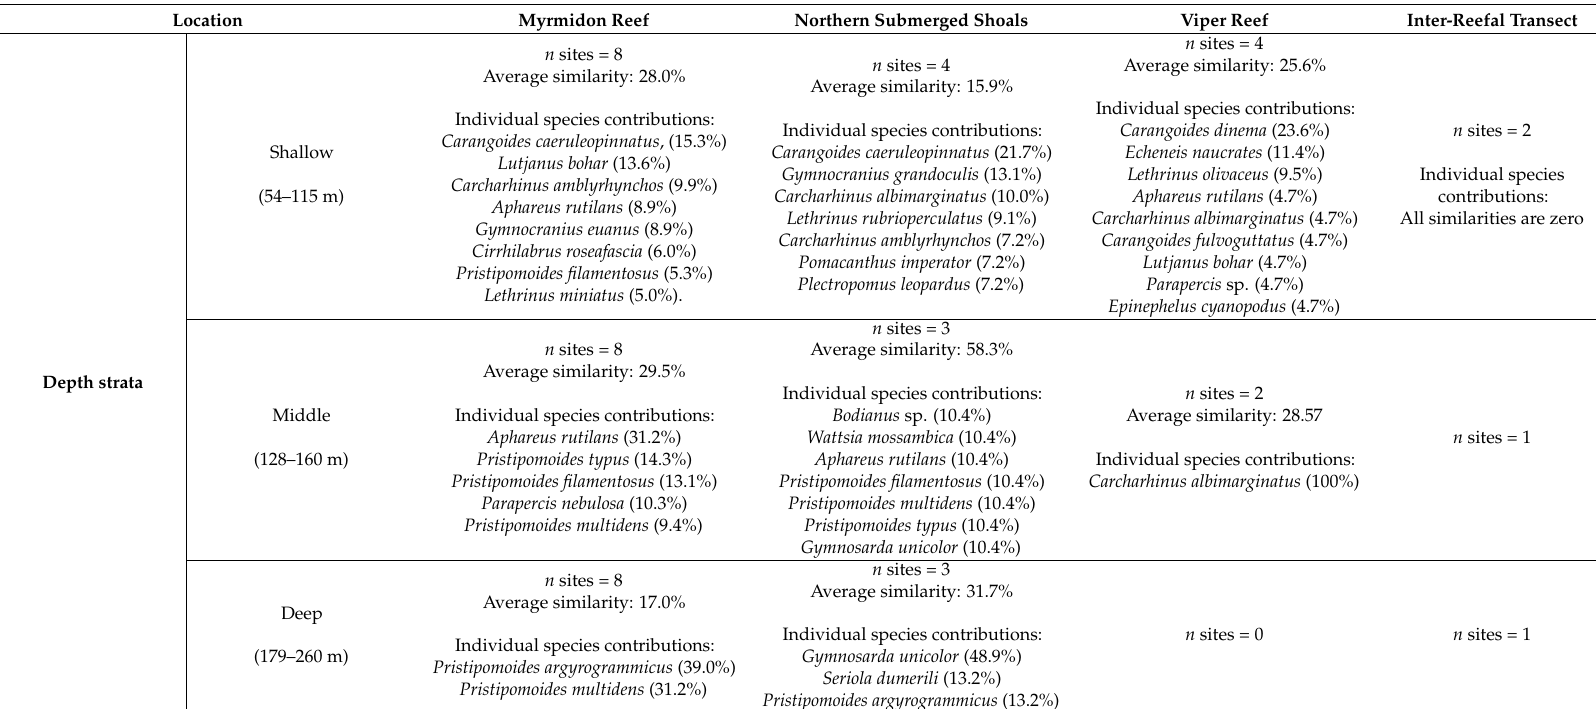
Table 2. Similarity percentages (SIMPER) analysis on deep-reef fish community data described the relative contributions of specific species to the dissimilarities between sites (among locations) with percent contribution of individual species to those differences. Species abundances were presence/absence-transformed, and Bray-Curtis similarity measures were used. Species contributing to ~70% combined are